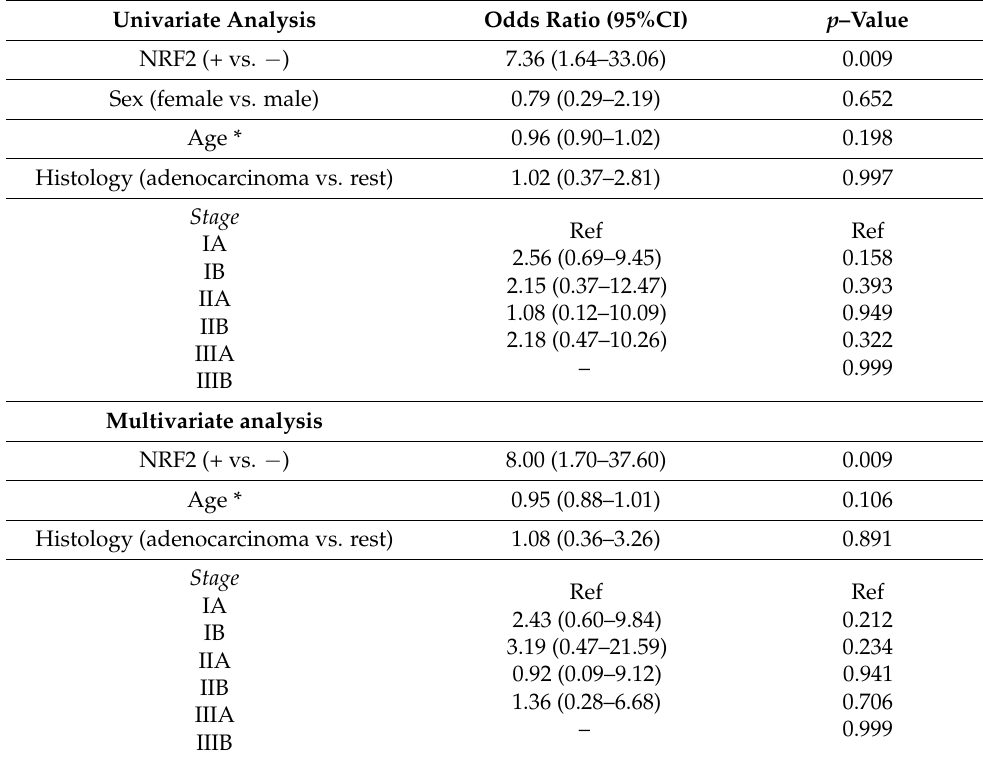
Table 3. Binary logistic regression analysis for the patients who relapsed in the CNS vs. those who did